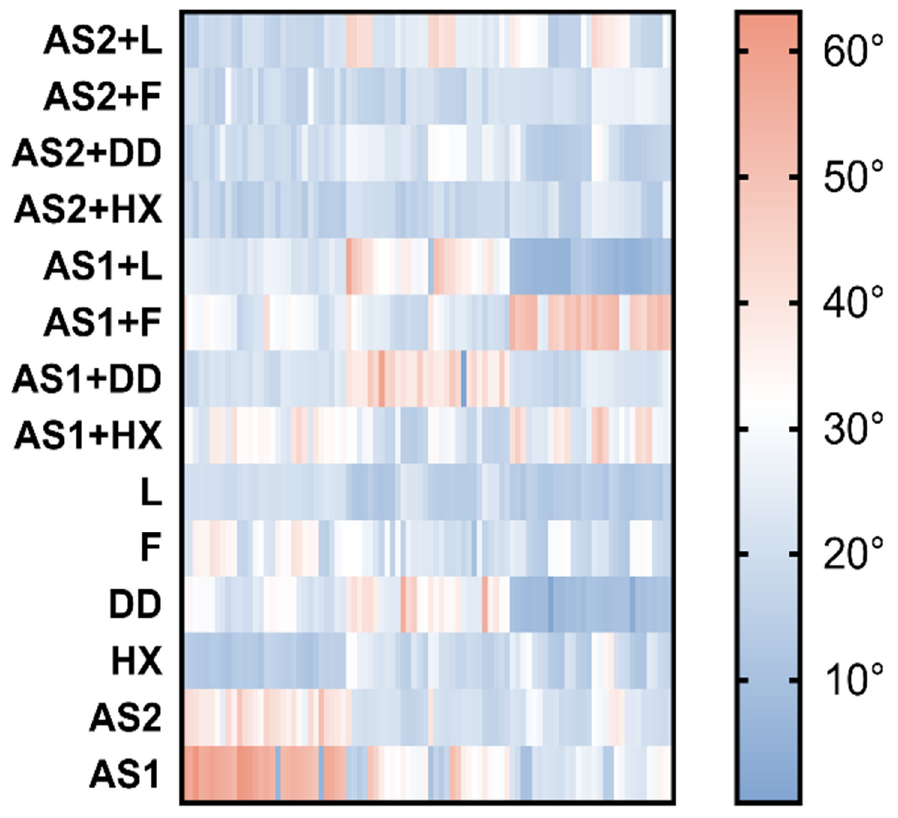
Figure 6. Heat map showing the contact angle range in 14 analyzed specimens in all measurements. Table 3. Contact angles, pH, and conductivity of the tested solution at room